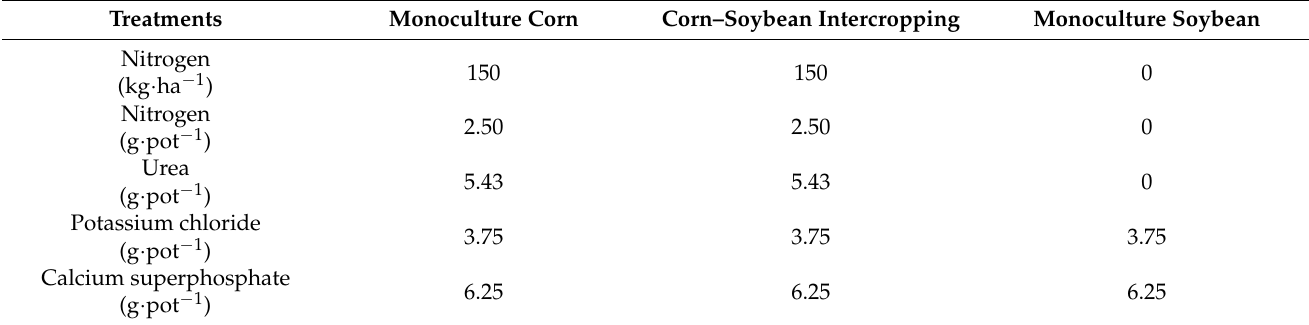
Table 5. Fertilizer